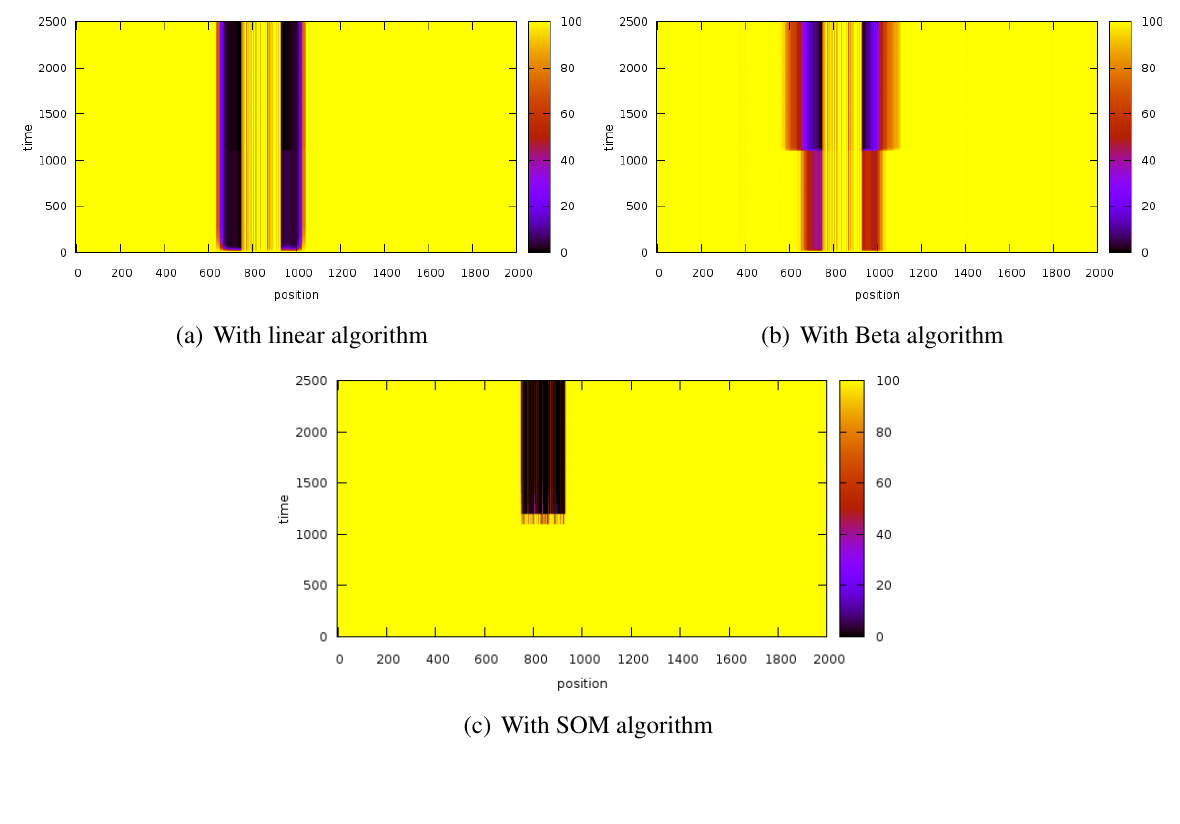
Figure 6. Reputation evolution for a sybil attack after a badmouthing